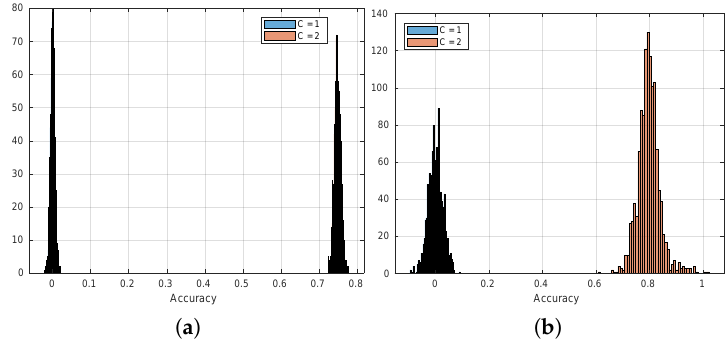
Figure A12. Histograms for the conclusions about the effect of factor C on the expected accuracy performance, represented for the two levels of such factor with additional restrictions on the population. ( a ) Factor B = 1. ( b ) Factor B =